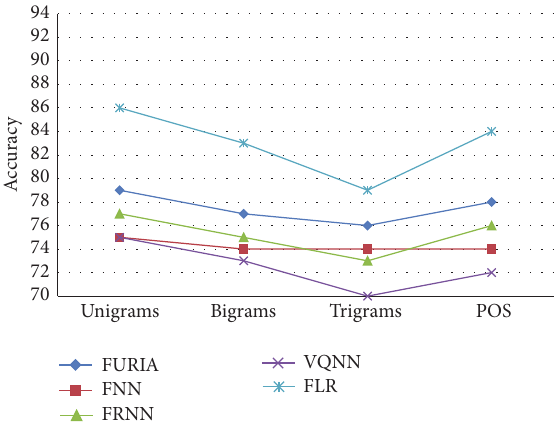
Figure 5: Classifiers performance with different feature types on hotels dataset.